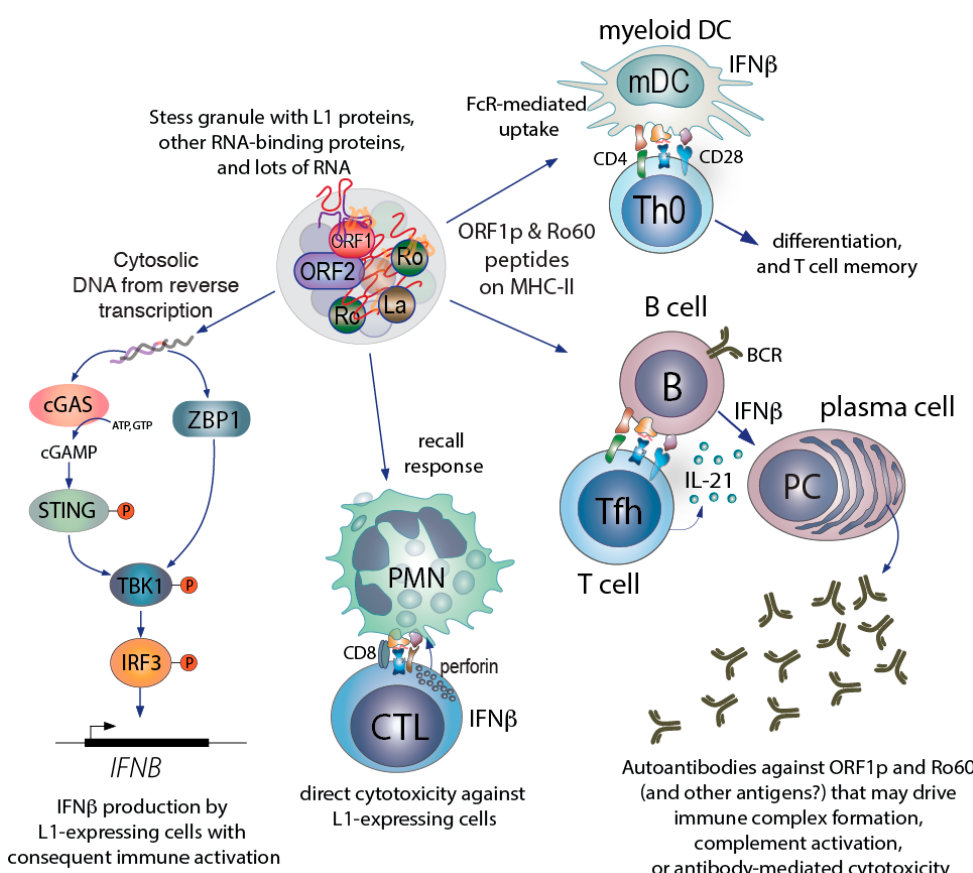
Figure 3. How the L1-containing stress granule may participate in driving SLE-related autoimmunity. The initial priming of T cells likely occurs by dendritic cells, which can take up stress granules, process their contents, and present peptides on class II MHC. The production of autoantibodies against ORF1p and Ro60 likely involves T cells primed by DC, followed by differentiation into follicular or peripheral helper T cells. CD8 T cells derived by cross-priming likely can recognized L1-expressing cells by virtue of ORF1p (and Ro60) derived peptides on class I MHC. Intracellularly, the reverse transcription of L1 transcripts into DNA will trigger IFN β production and secretion. The secreted IFN β will further stimulate monocyte differentiation to myeloid DC, plasma cell differentiation, and the differentiation and activation of CD8 T cells to become cytotoxic. Some cells do not express cGAS, but instead have other DNA sensors, such as Z-DNA binding protein 1, ZBP1, which also induce IFN β production. Lastly (and not specifically illustrated), immune complexes that contain ORF1p, Ro60, and RNA (i.e., stress granules) will be taken up by plasmacytoid dendritic cells and B cells to trigger TLR-mediated IFN α